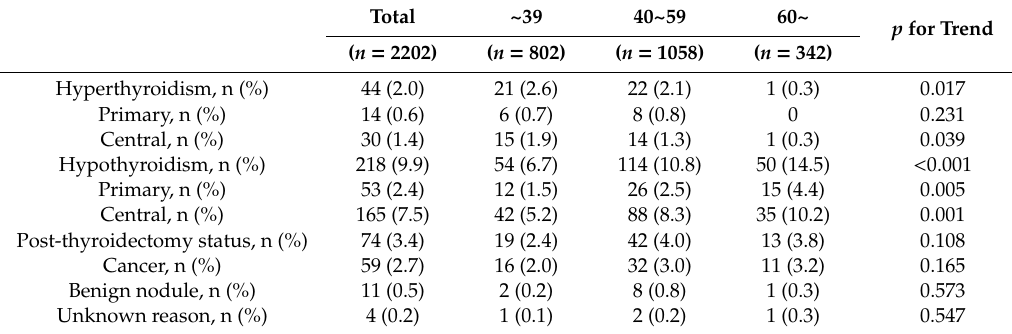
Table 2. Prevalence of thyroid disease according to